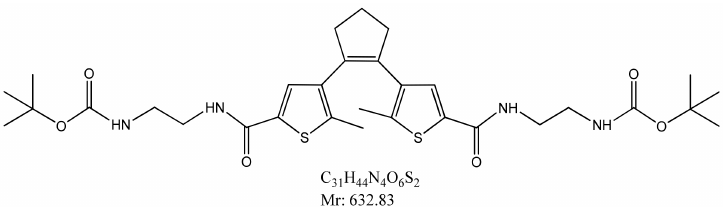
Figure 15. di-tert-butyl(((4,4’-(cyclopent-1-ene-1,2-diyl)bis(5-methylthiophene-4,2-diyl-2-carbonyl))bis (azanediyl))bis(ethane-2,1-diyl))dicarbamate (DAE-NH-Boc). 1 H NMR (300 MHz, CDCl δ 7.23 (s, 2H, 2CH, DAE), 6.85 (br s, 2H, 2NH), 5.05 (br 3 ) s, 2H, 2NH), 3.48 (q, J = 10.6, 5.0 Hz, 4H, 2CH 2 ), 3.35 (q, J = 4.6 Hz, 4H, 2CH 2 ), 2.76 (t,